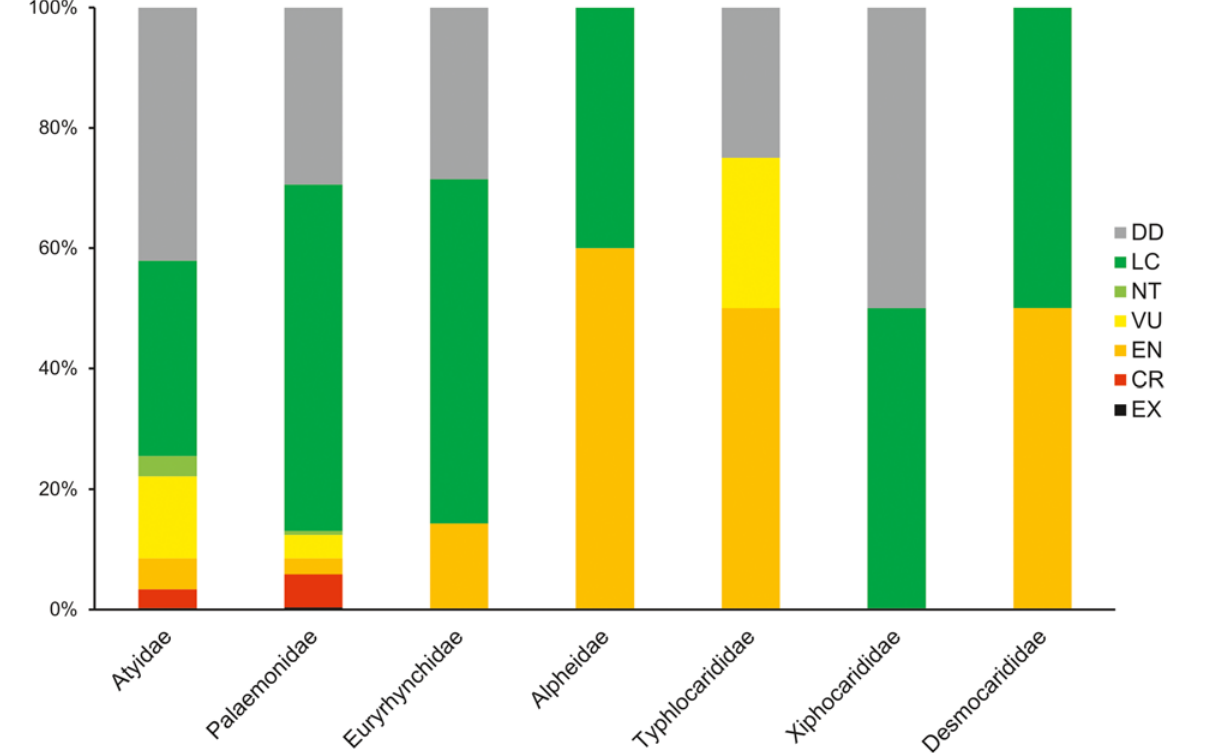
Fig 5. Extinction risk in the various shrimp families, expressed as a percentage of species richness per